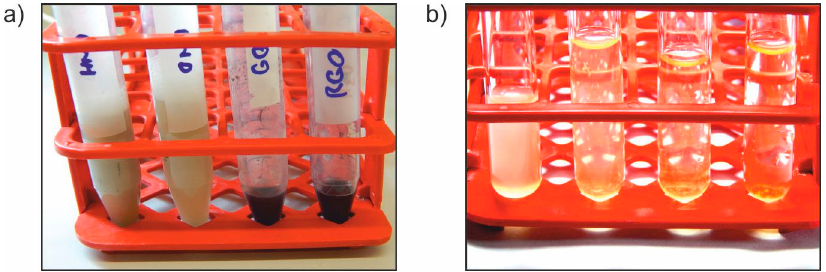
Figure 1. Photographs of ( a ) vials with nanodiamond (HND), air annealed nanodiamond (OND), graphene oxide sheets (GO) and reduced graphene oxide sheets (rGO) (from the left to the right) stock dispersions (2 mg/mL) in distilled water and ( b ) vials with different concentrations of E. coli in the Mueller Hinton (MH) broth (from the left to the right decreasing relative concentrations related to the original one marked as 10 0 , 10 − 1 , 10 − 2 and 10 − 3